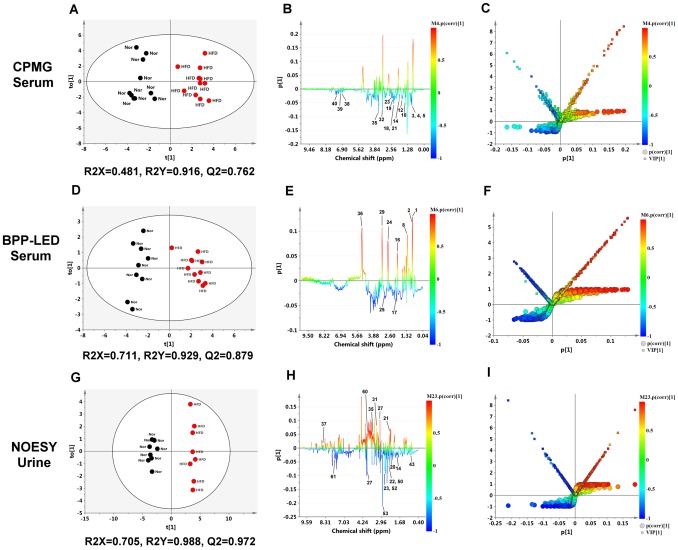
O-PLS-DA results for normal chow diet and high fat diet-fed mice derived from 1H NMR CPMG spectra of serum (A, B, C), BPP-LED spectra of serum (D, E, F), and NOESY spectra of urine (G, H, I).O-PLS-DA scores plots (A, D, G), coefficient-coded loadings plots (B, E, H), and the S-plot combined with the VIP plot and color coefficient scale bar (C, F, I) for the models discriminating the normal group (black filled dots) and HFD groups (red filled dots) based on data for plasma and urine. Metabolite keys to the number are shown in
Table 1

 and

Table 2

. Nor, normal group; HFD, high fat diet group.